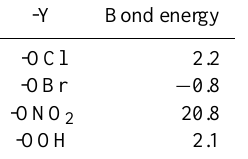
Table 3. Hg-Y bond energies (kJ/mol) at a temperature of 0K using CCSD(T)/aVTZ single point energies computed with B3LYP/aVTZ structures and zero-point energy corrections (negative sign indicates dissociation to Hg+Y is computed to be energetically favored). For Y=ClO and BrO, only the isomer with bonding between the oxy- gen and mercury was considered (see text). -Y 2.2